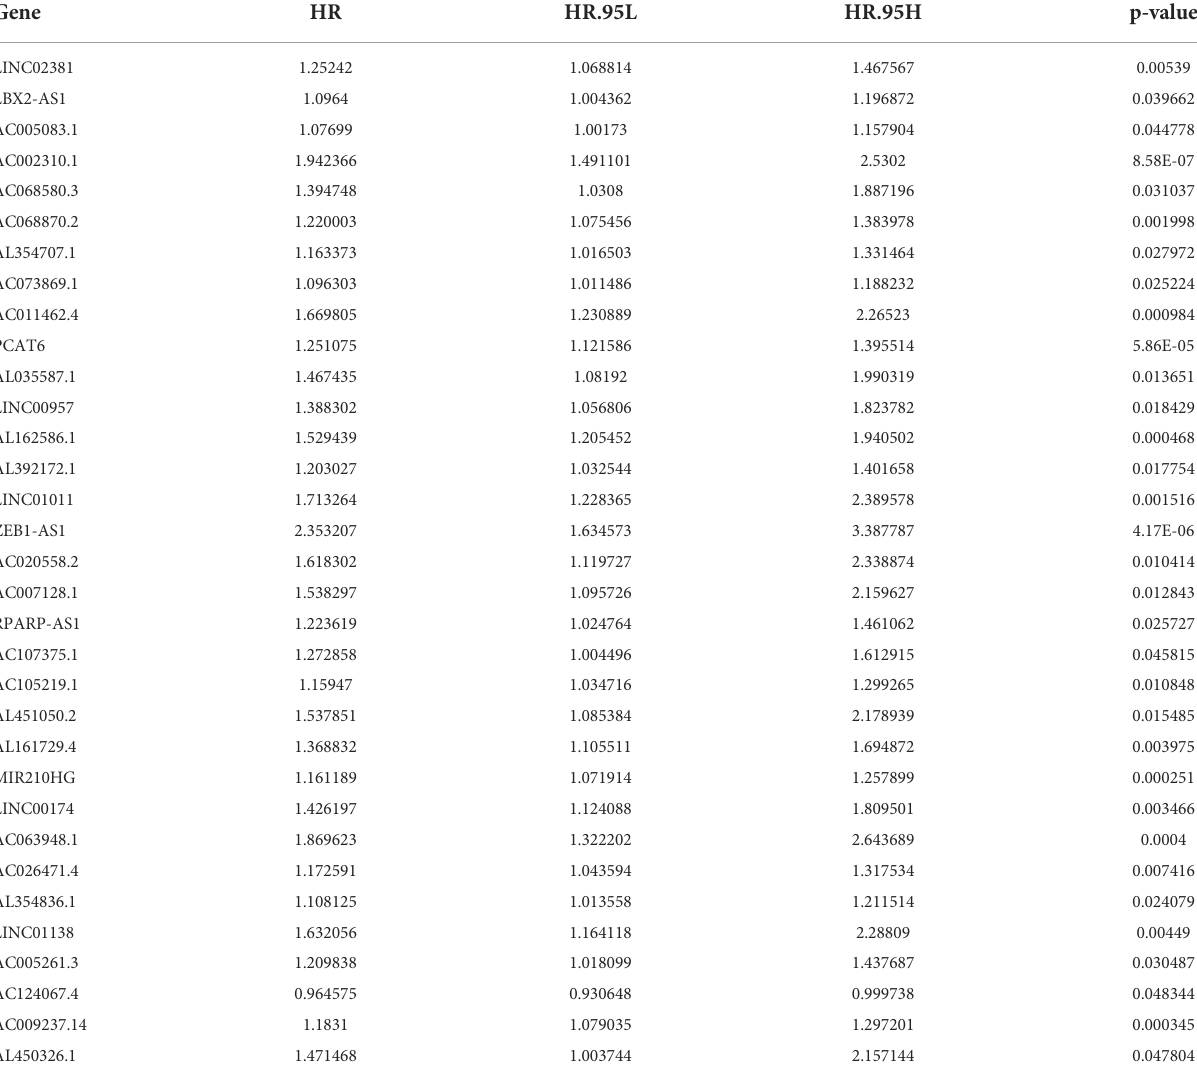
TABLE 2 Thirty-three GT-related lncRNA associated with prognosis in patients with COAD. Gene